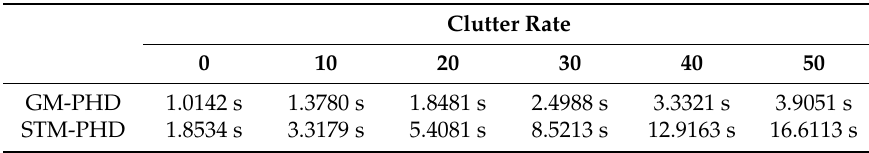
Table 4. Average computing time with different clutter